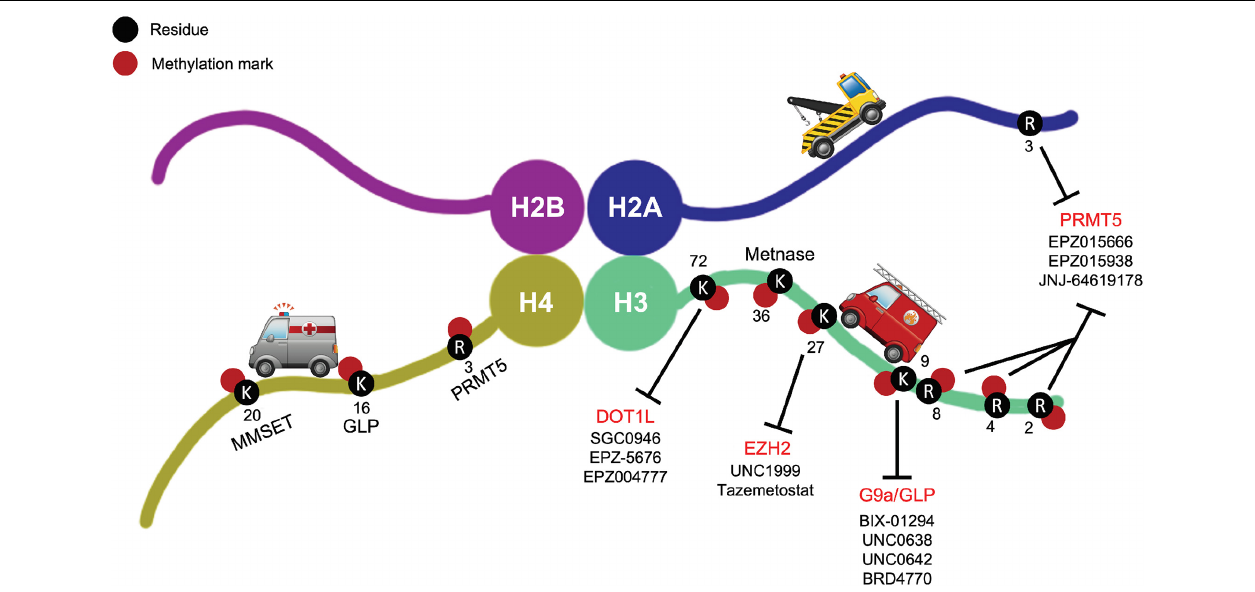
FIGURE 2 | Small molecule inhibitors of DOT1L, G9a/GLP, EZH2, and PRMT5 shown with their respective target methylation marks on the histone tails. These are examples of prominent small molecule HMT inhibitors in pre-clinical testing or early stages of clinical trials as part of promising standalone or combinatorial cancer